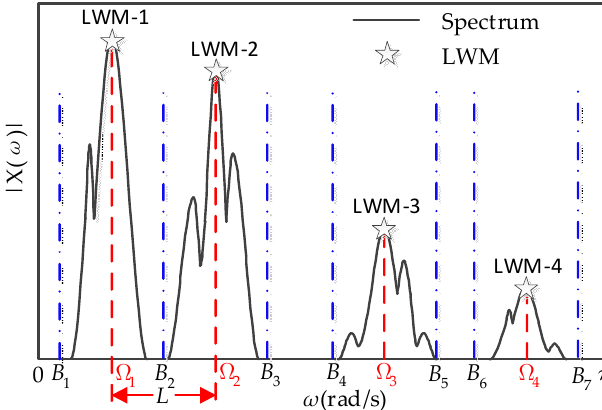
Figure 4. The detected boundaries which are denoted by the blue dot-dashed lines, the four LWM and the minimum distance of two adjacent LWM.